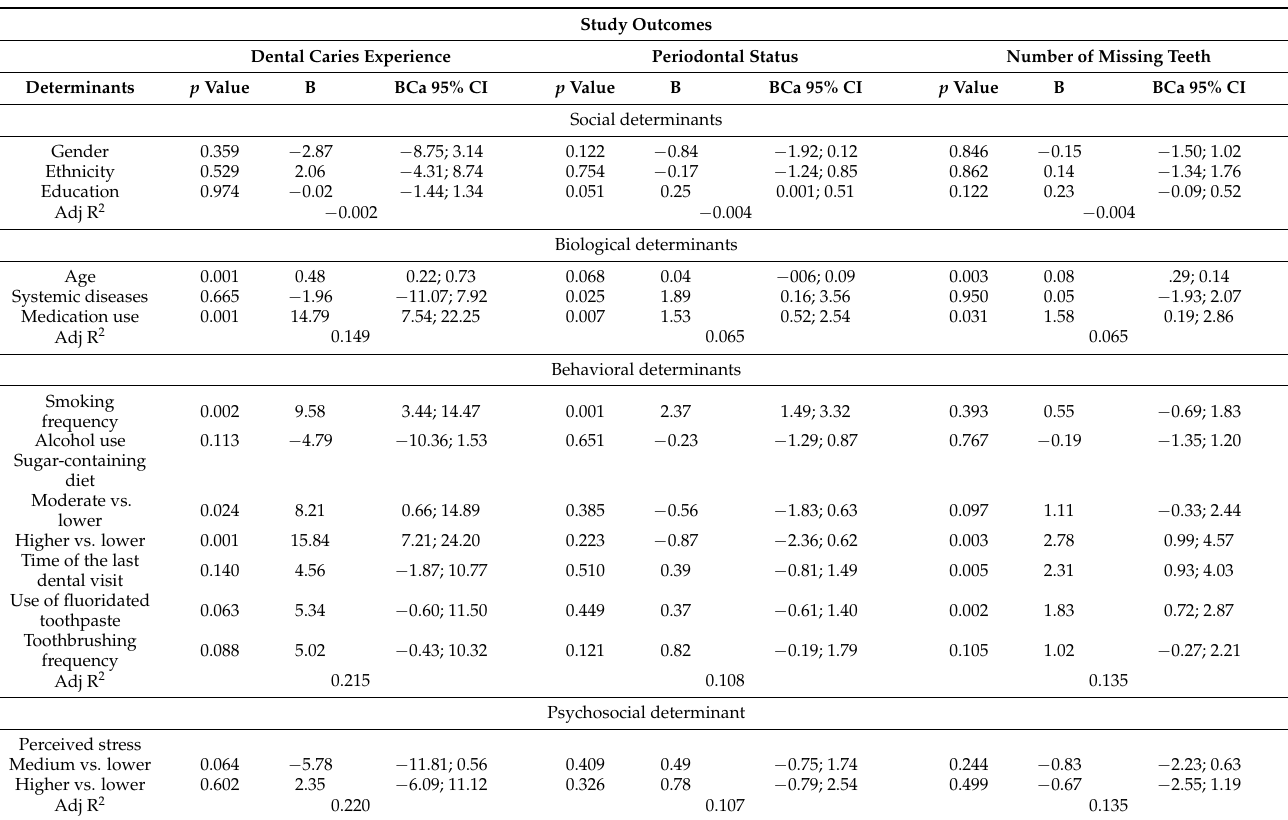
Table 3. Determinants of dental caries experience, periodontal status, and number of missing teeth in Vilnius residents (multivariable linear regression). Study